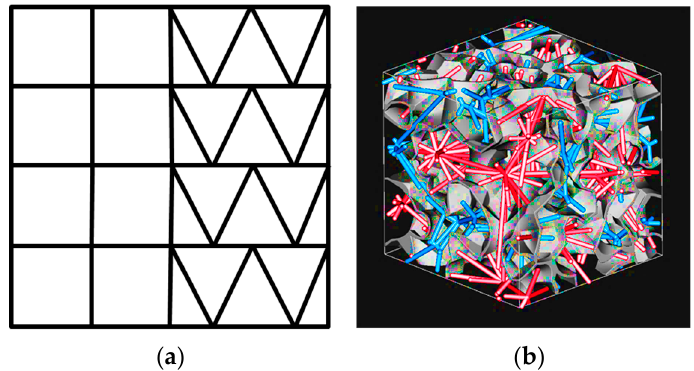
Figure 14. Two levels of feature selection to which hybridization may be applied: ( a ) the unit cell or ( b ) the member (two non-intersecting lattices indicated with different colors, inside a surface-based cellular material).